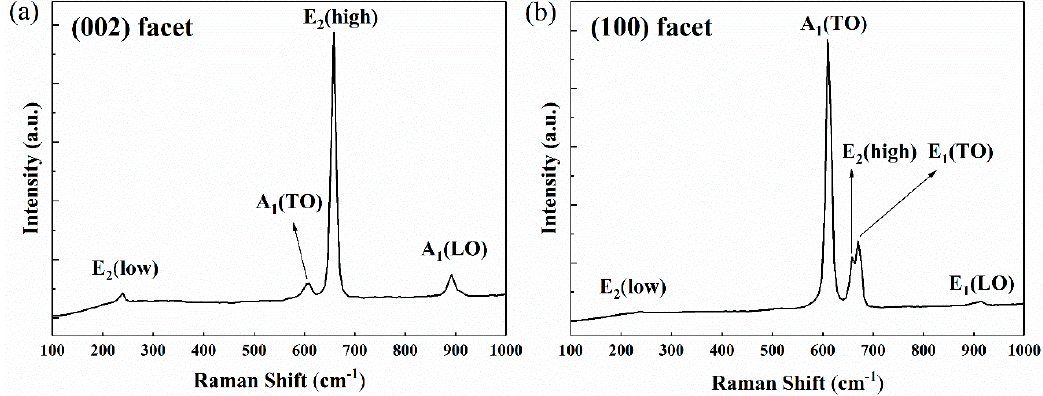
Figure 5. Raman spectra taken on (002) facet ( a ) and (100) facet ( b ) of the prepared bulk AlN single crystal at room temperature (300 K).